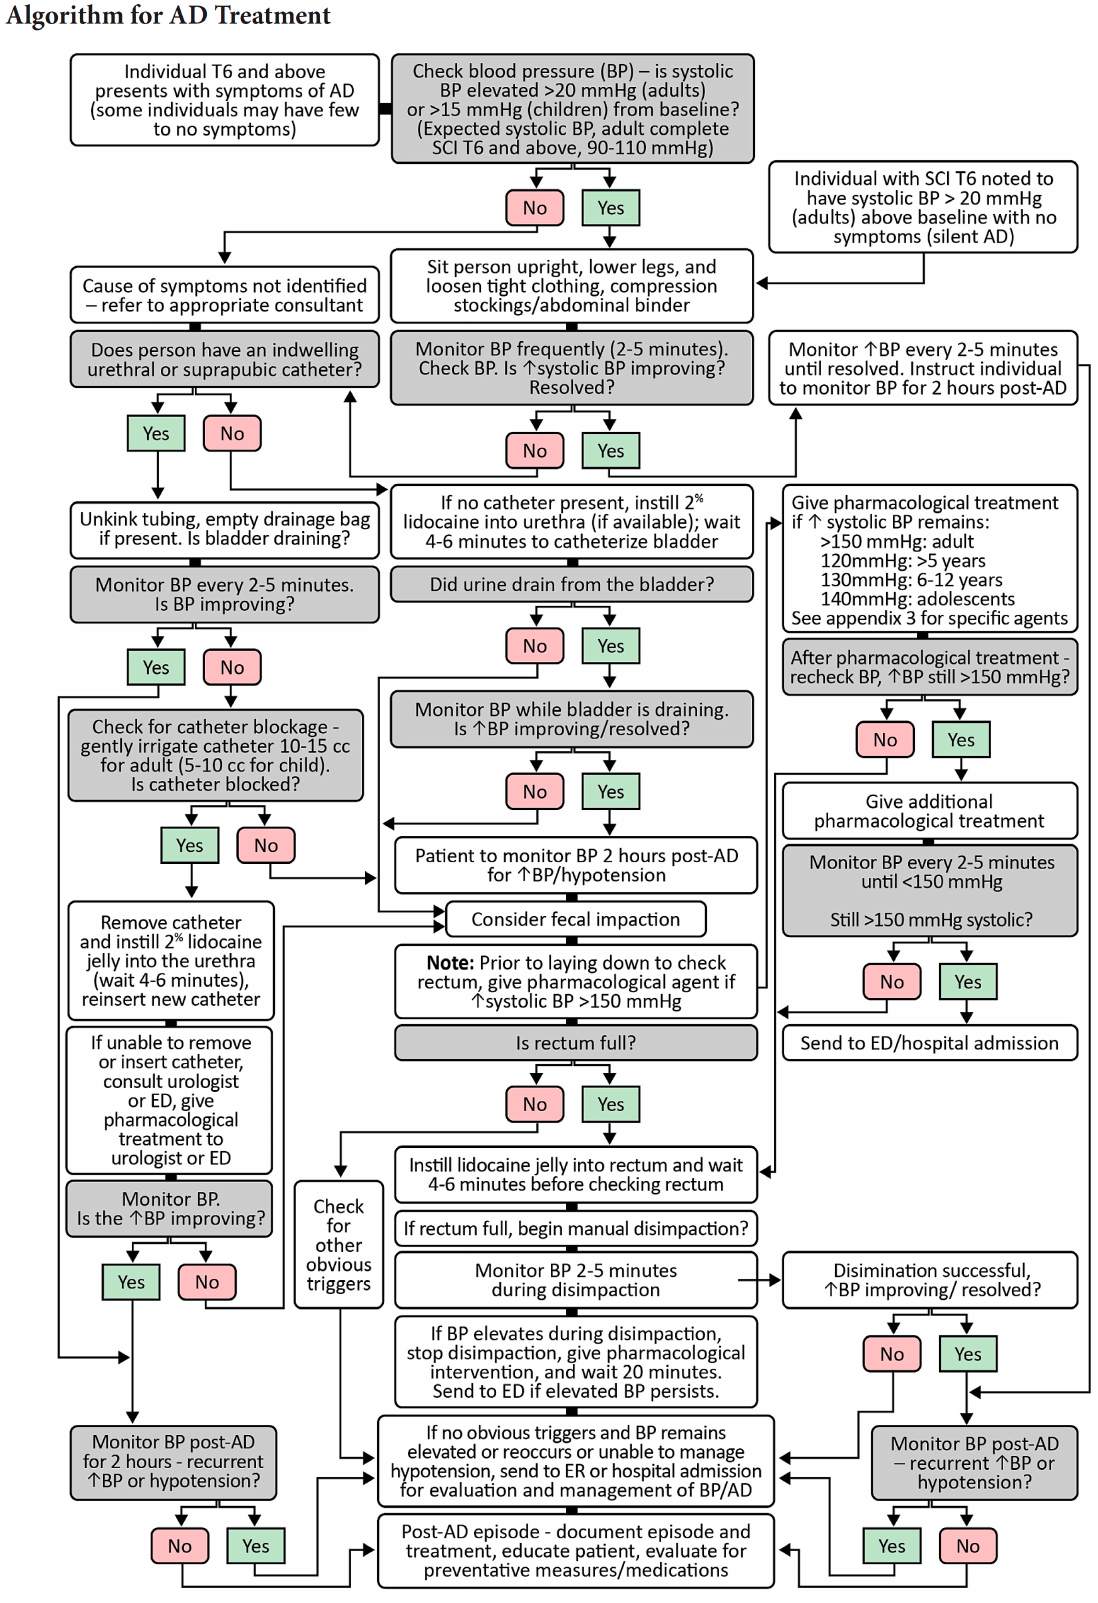
Figure 3. Management algorithm for Autonomic Dysreflexia. Reprinted with permission from Topics in Spinal Cord Injury Rehabilitation, Evaluation and Management of Autonomic Dysreflexia and Other Autonomic Dysfunctions: Preventing the Highs and Lows: Management of Blood Pressure, Sweating, and Temperature Dysfunction. Krassioukov et al. TSCIR 2021;27(2):225–290. Copyright 2021 by American Spinal Injury Association.